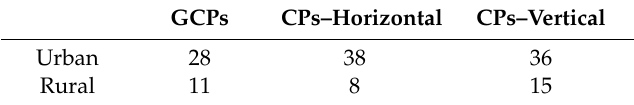
Table 2. The numbers of GCPs and control points (CPs) in the individual study areas.